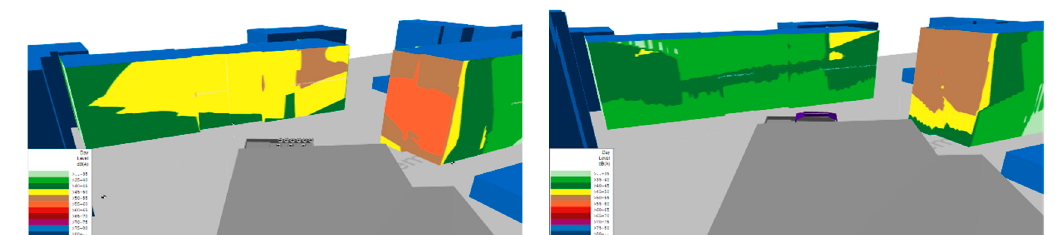
Figure 11. Lday—façade calculation plots ( left : Scenario 2, right : Scenario 5) .